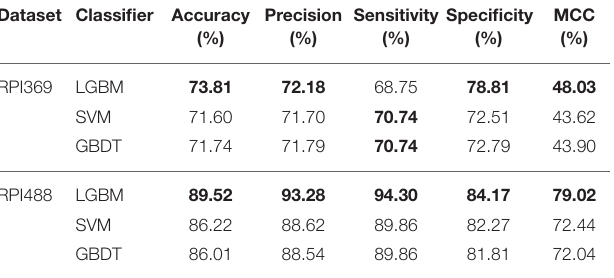
TABLE 4 | Performance evaluation on different classifiers. Dataset Classifier Accuracy (%)